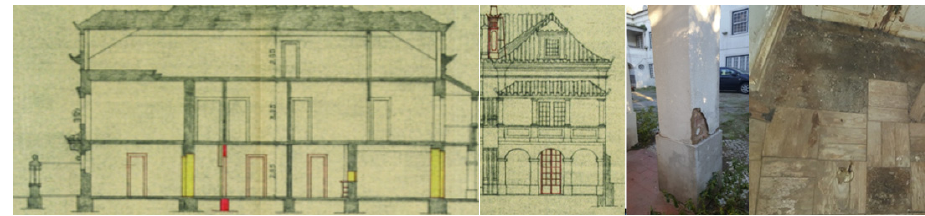
Figure 8. Drawings of yellow and red indicators, and images of damage.